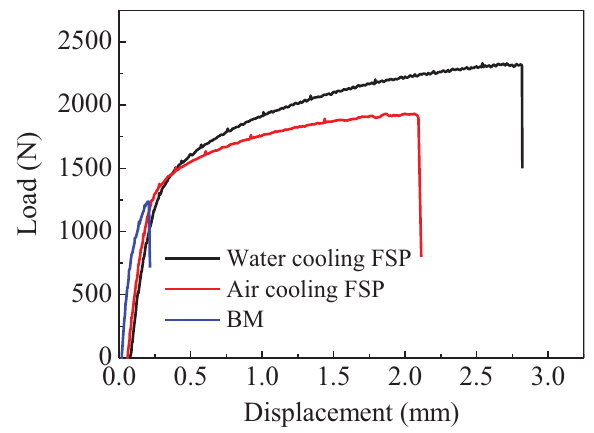
Figure 8: Load – displacement curves of these specimens.